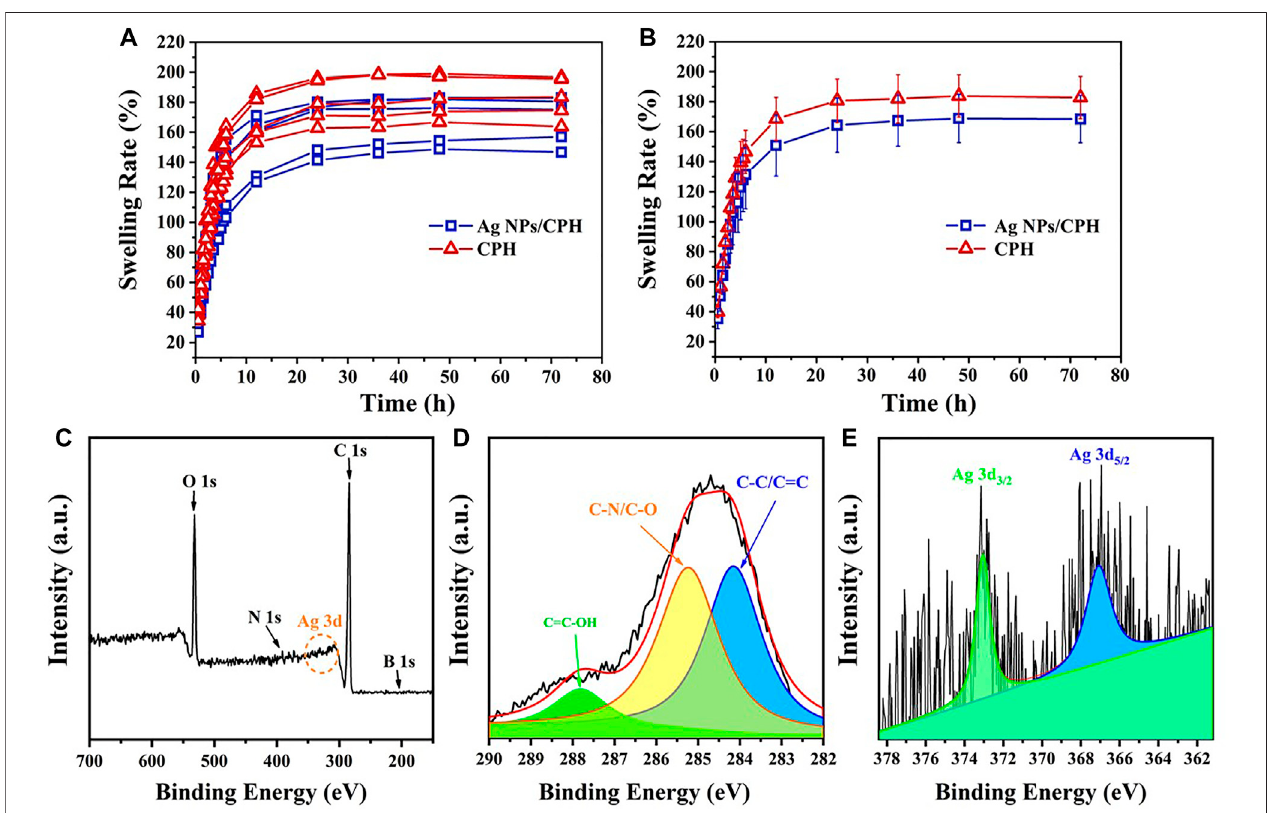
FIGURE3|(A) Tenvolumeswellingcurvesforthe fi veCPHandAgNPs/CPHsamplegroupsfrom0to72 h. (B) Thestatisticalresultcurveof (A) . (C) Bullscanning XPS spectrum of Ag NPs/CPH. (D,E) show the high-resolution XPS spectra of C 1s and Ag 3d, respectively.